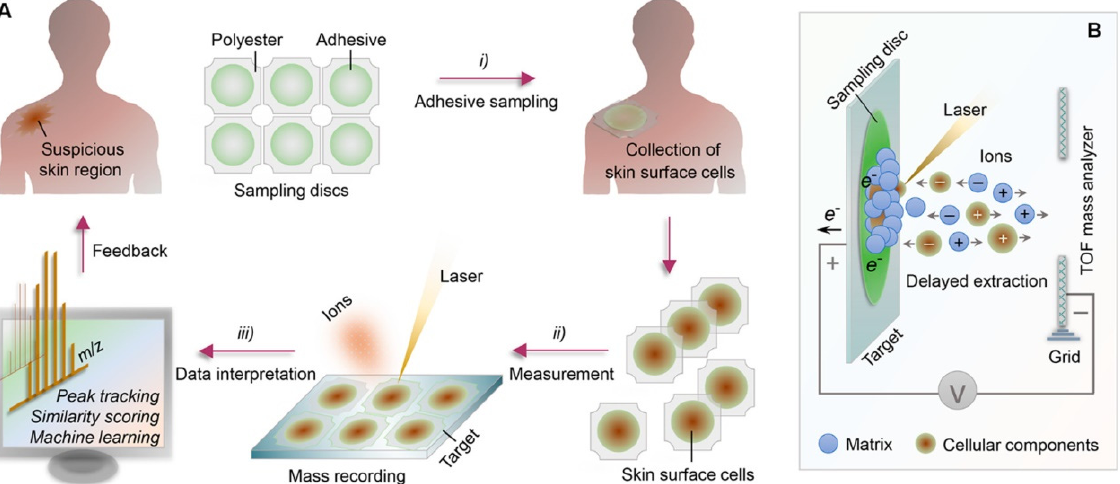
Figure 10. ( A ) Schematic representation of the methodology used for skin diagnosing. ( B ) Representation of matrix-assisted laser desorption ionization time-of-flight (MALDI-TOF) mass spectroscopy.